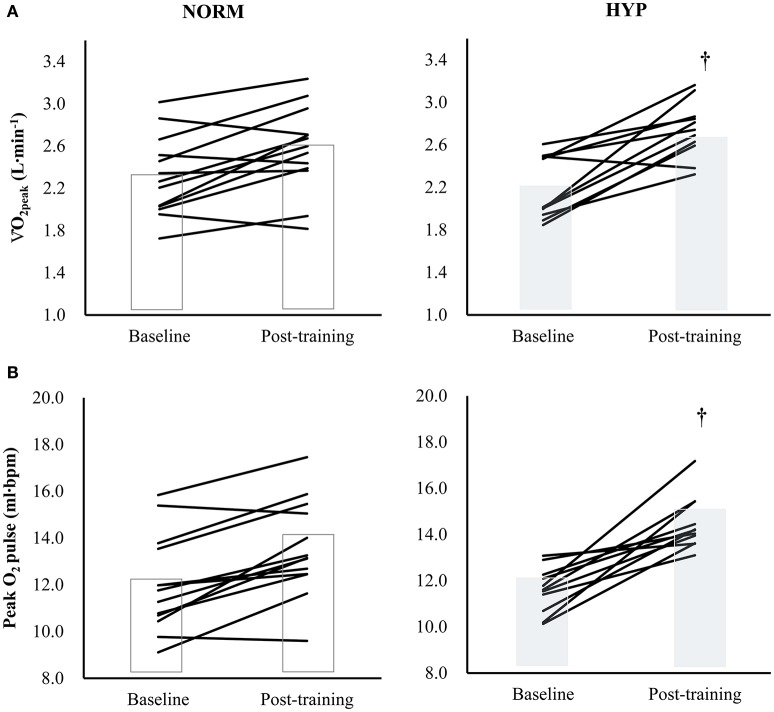
The changes in (A)
V·O2peak[partial η2 = 0.626 (time); 0.144 (group); 0.177 (time × group)] and (B) Peak O2 pulse [partial η2 = 0.736 (time); 0.229 (group); 0.216 (time × group)] in individual participants (solid lines) and groups (bars) after 5-wk HIIT under normoxia (NORM, n = 13) and normobaric hypoxia (HYP, n = 11). †Significantly different from corresponding NORM value (p < 0.05); HIIT: high-intensity interval training.